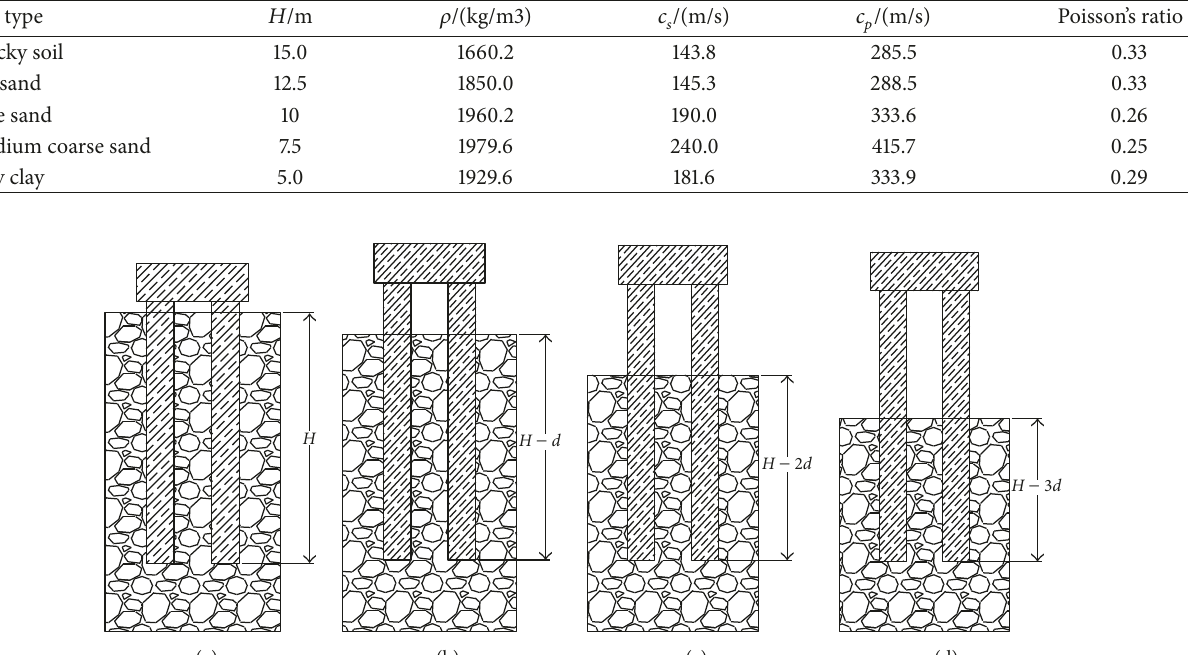
Figure 3: Sketch of decrease of the effective friction area between piles and soil. The embedded depth of piles was designed as (a) 𝐻 , (b) 𝐻 − 𝑑 , (c) 𝐻 − 2𝑑 , and (d) 𝐻 − 3𝑑 .